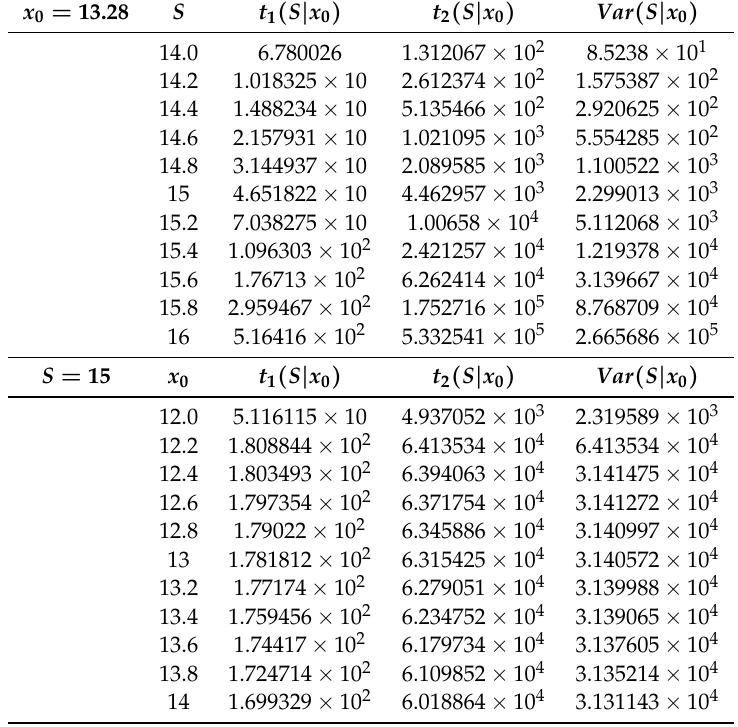
Table 5. For Dataset A, second period, mean, second order moment, and variance of the random variable T x through various values of the threshold S (on the top) and for various values of x 0 0 (on the